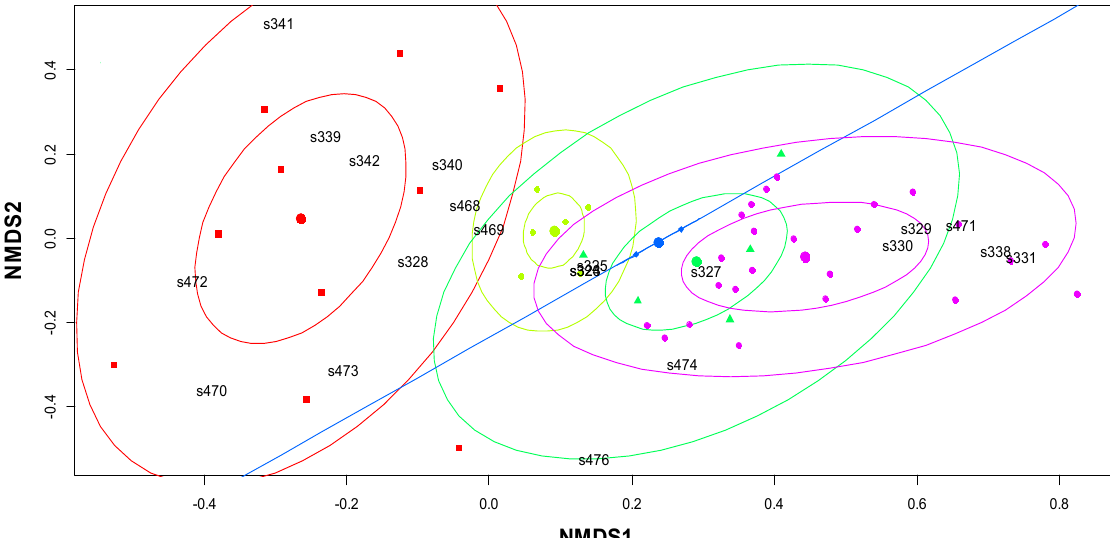
Figure 3. Multidimensional scaling of four groups proposed by population structure analysis for genotypes of purple passion fruit ( P. edulis f. edulis ) based on 966 SNP markers generated through genotyping by sequencing (GBS). Group 1 in red, 2 in light green, 3 in dark green, and 4 in purple. The central trend is represented by a blue line. The major SNPs are highlighted with a lowercase “s” followed by a number. The central tendency is represented by a dark blue line and distance from the centroid spot on the line.